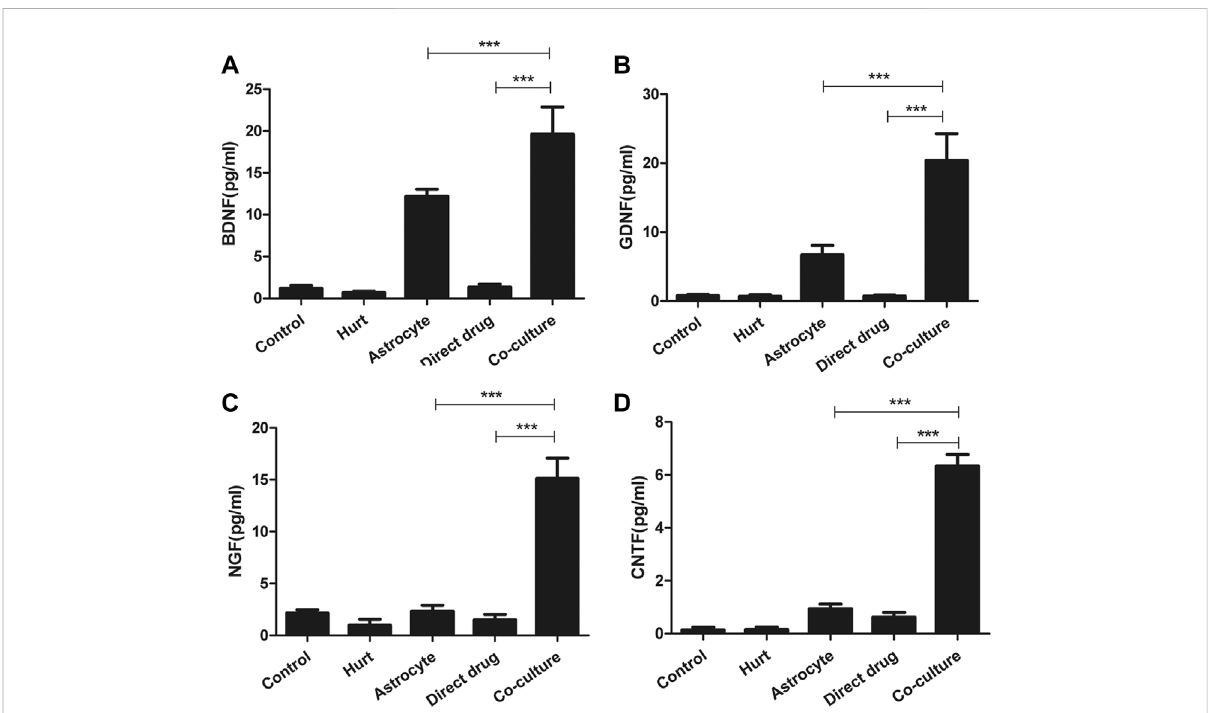
FIGURE 12 TFHL promotes secretion of neurotrophic factors by astrocytes. (A – D) The secretion of BDNF, GDNF, NGF, and CNTF in each group was detected by ELISA. The comparison of the contents of BDNF, GDNF, NGF, and CNTF in the culture medium of each group. All data are expressed as themean±SD.Differencesamonggroupsweredeterminedwithone-wayANOVAfollowedbyaleast-signi fi cantdifferenceposthoctest.* p < 0.05, ** p < 0.01, *** p <